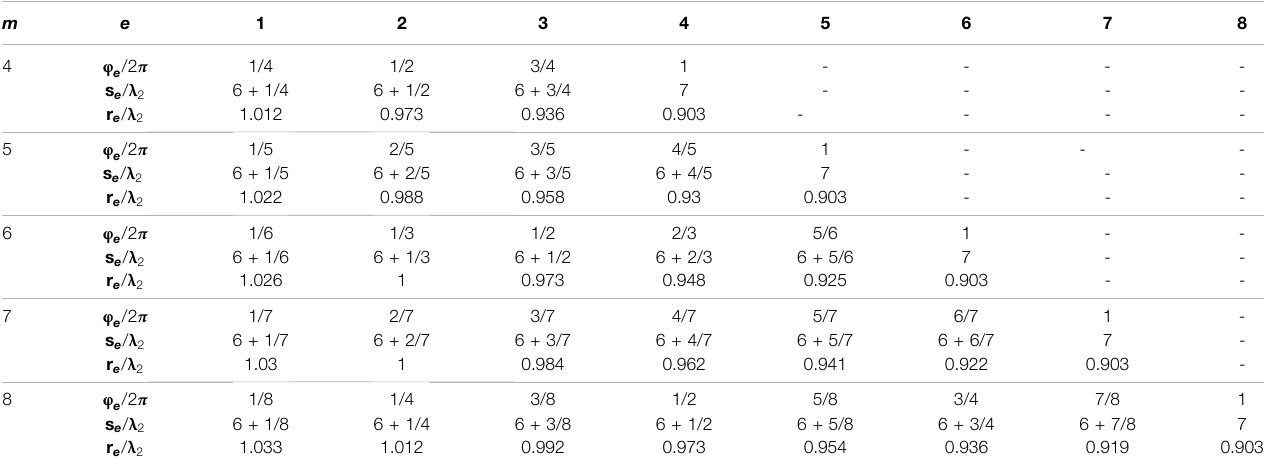
TABLE 1 | Values of phase φ , length s and parameters r corresponding to metasurfaces with different unit cell numbers after phase redistribution.